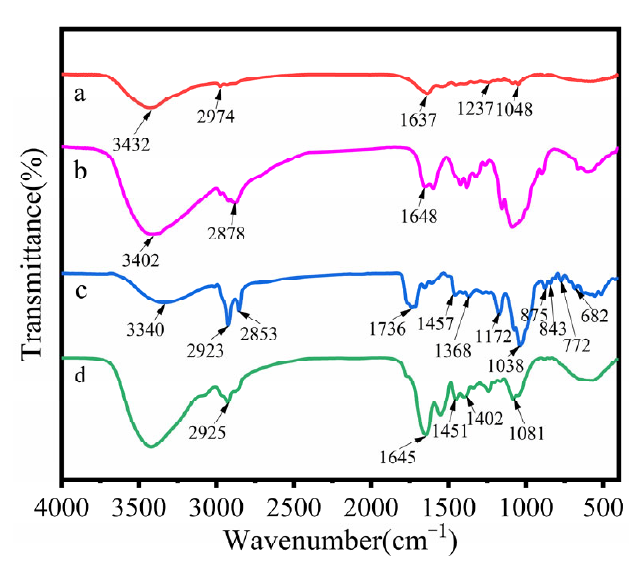
Figure 9. FTIR spectra: a = gelatin; b = chitosan; c = SPEO; d = SPEO microcapsules.